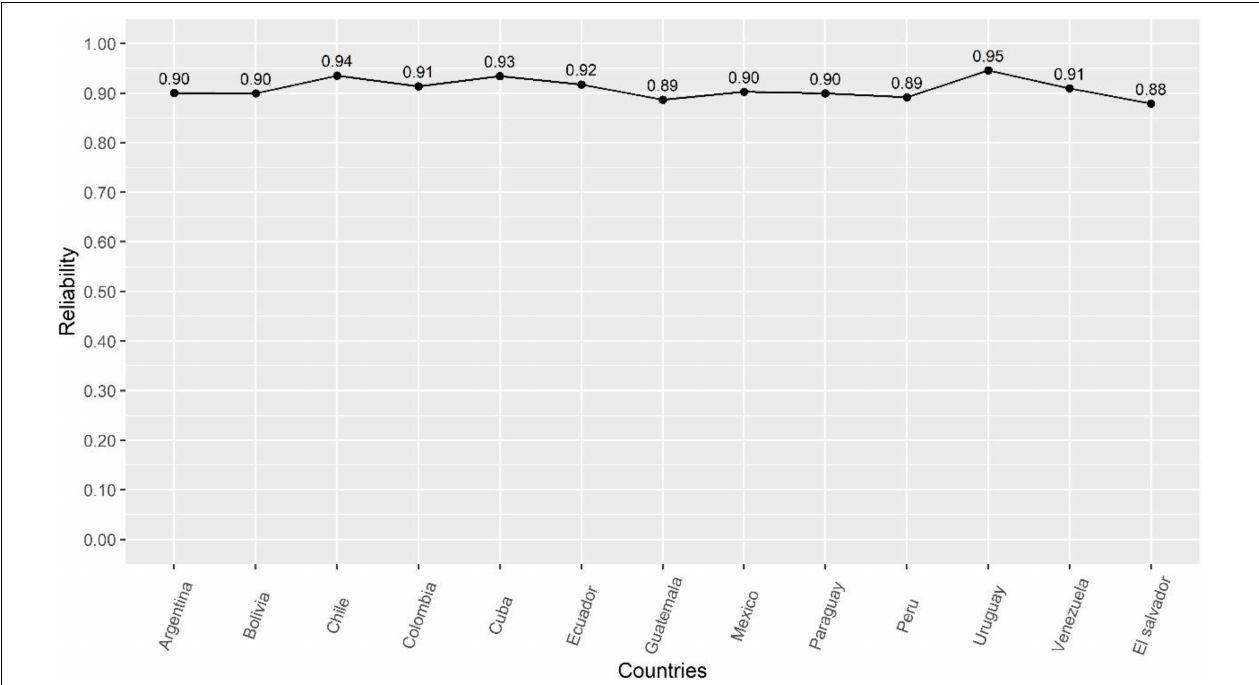
FIGURE 1 | Reliability of the ECCV-COVID in the 13 Latin American